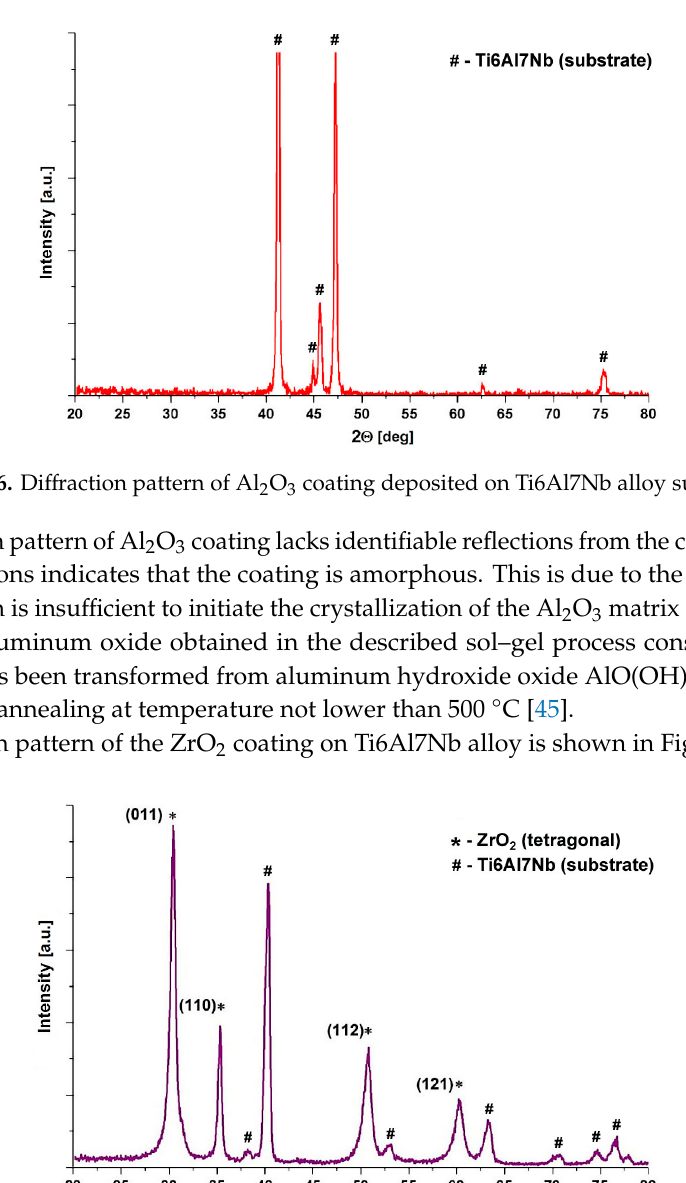
Figure 8. Diffraction pattern of HAp coating deposited on the Ti6Al7Nb alloy substrate. The reflections marked on the diffraction pattern were identified by means of ICDD card No. 01-080-7087 as reflections from the (111), (102), (121), (300), (302), (222), (312), and (402) planes of the hydroxyapatite unit cell provide evidence of the crystalline structure of the coating. 3.3. Hardness and Elastic Modulus The elastic modulus E and the hardness H were determined from the continuously recorded (CSM mode) indentation load displacement curves as proposed by Oliver and Pharr [42].